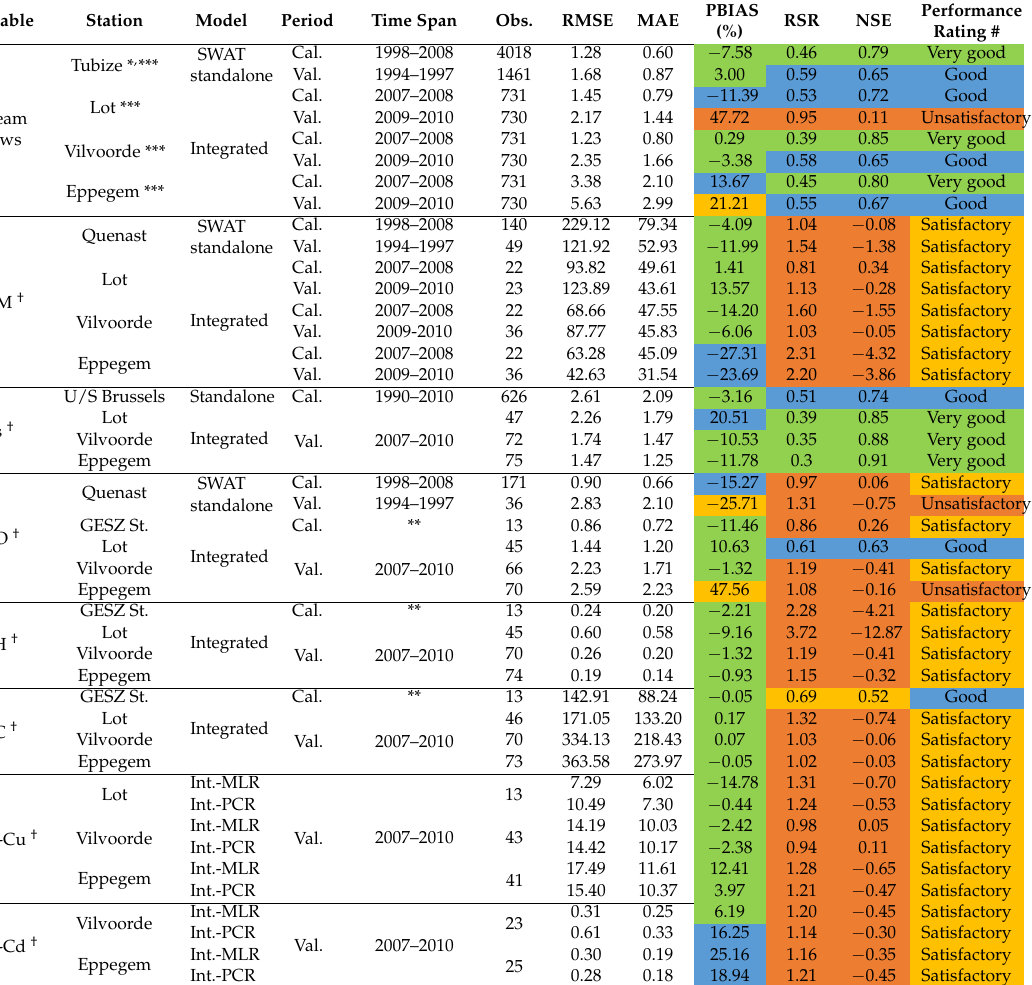
Table 5. Goodness-of-fit statistics and final performance rating of different model components of the integrated trace metal transport